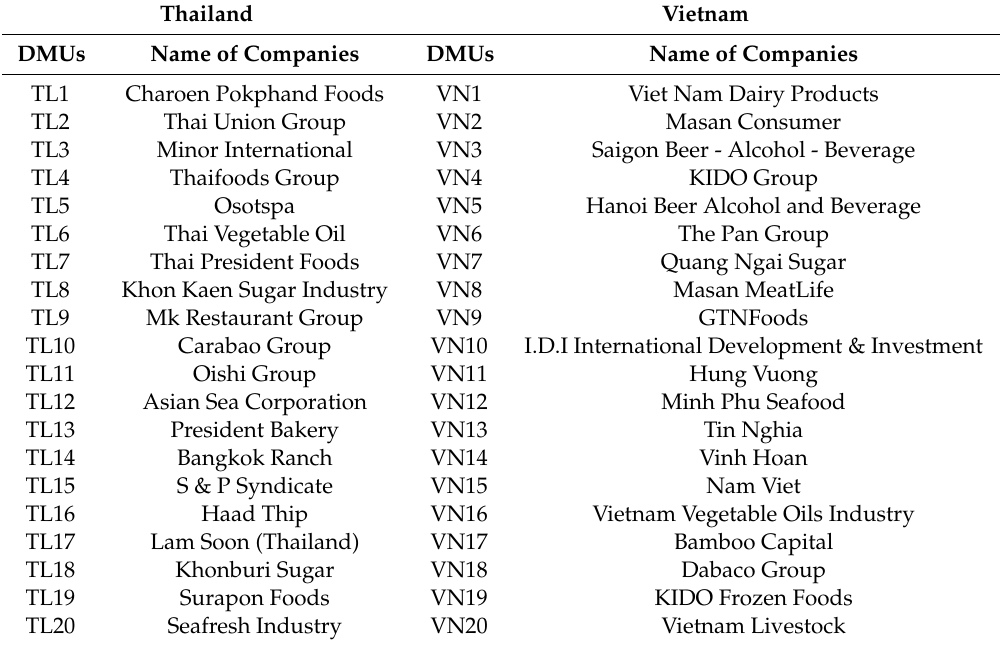
Table 1. The list of companies in Thailand’s and Vietnam’s F&B industry.